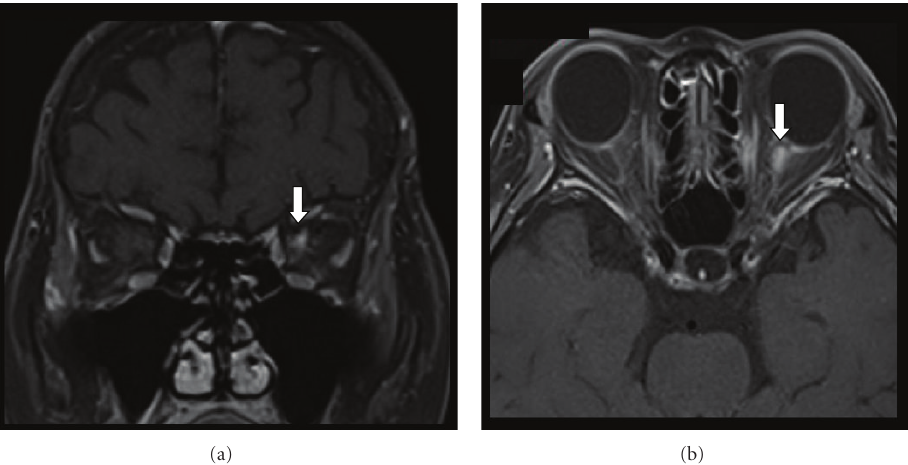
Figure 1: Brain magnetic resonance images with T1-weighted gadolinium enhancement performed 1 week after the onset of left visual loss. A high-intensity lesion on the left optic nerve is seen (white